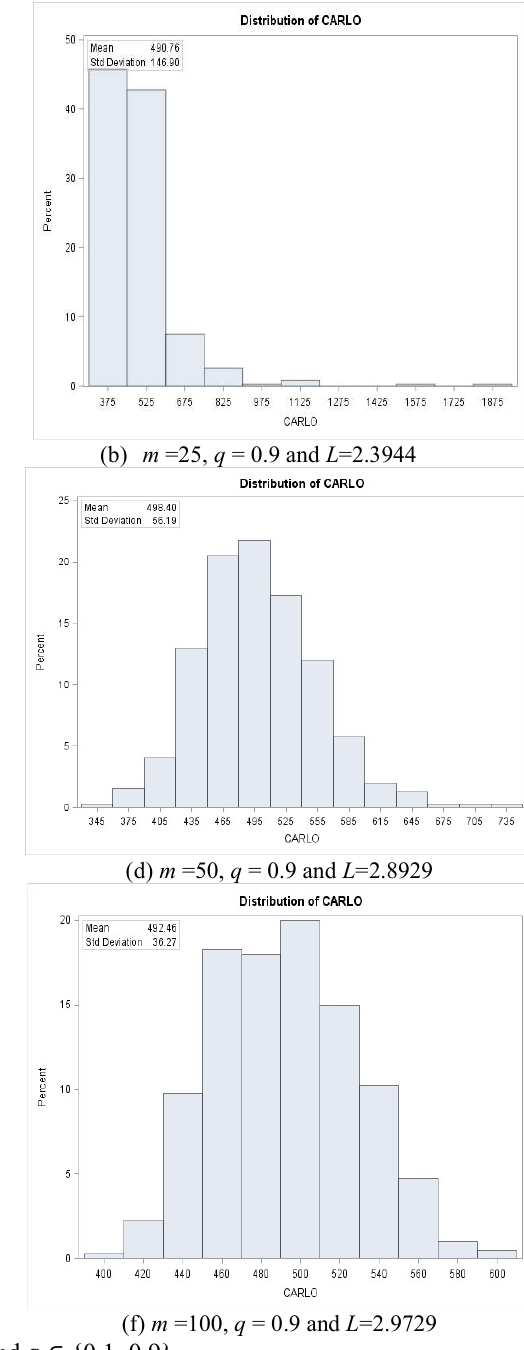
Fig. 4. Distribution of the 𝐶𝐴𝑅𝐿 of the proposed GWMA( 𝑞 , 𝛼 ) when m ∈ {25, 50, 100}, n = 5, 𝑞 ∈ {0.1, 0.9} (cid:2868) and 𝛼 ∈ {0.5, 1.5} in Case